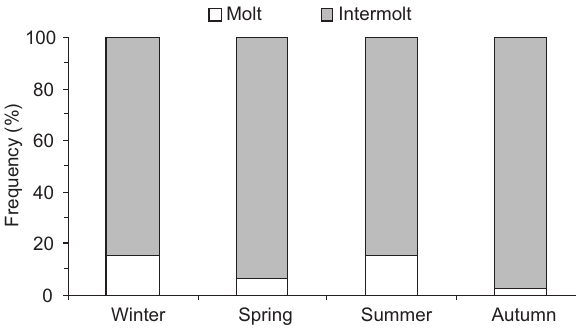
Figure 8. Frequency of U. rapax in molt activity and in intermolt by seasons from Itaipu Lagoon. The asteristics shows significant differences (p <